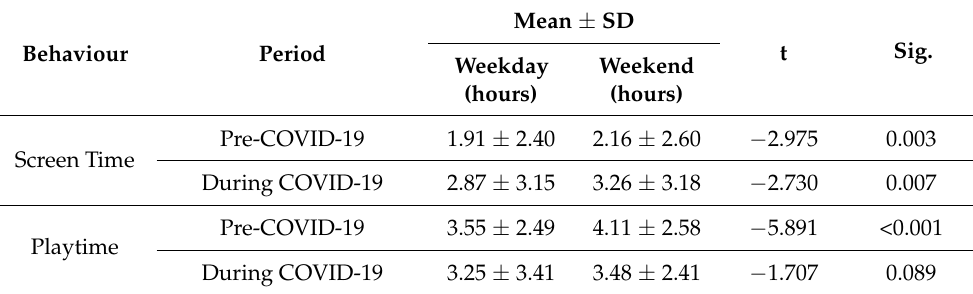
Table 2. Screen time and playtime of preschool children on a weekday and a weekend before and during the COVID-19